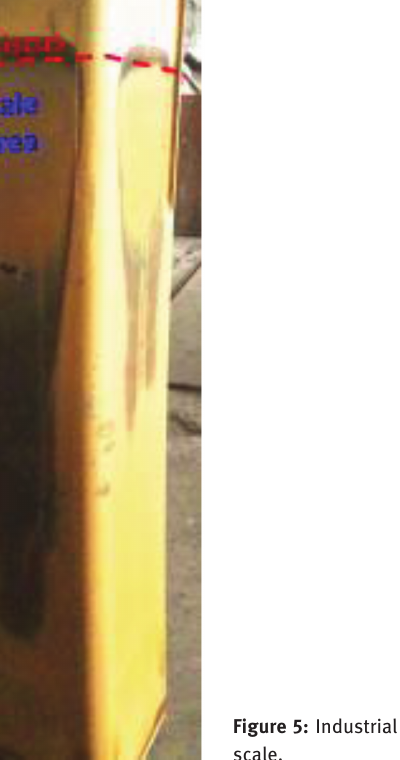
Figure 5: Industrial mold with scale.